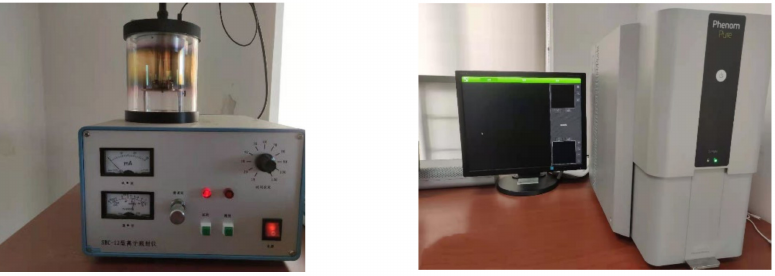
Figure 3. Field emission scanning electron microscope.